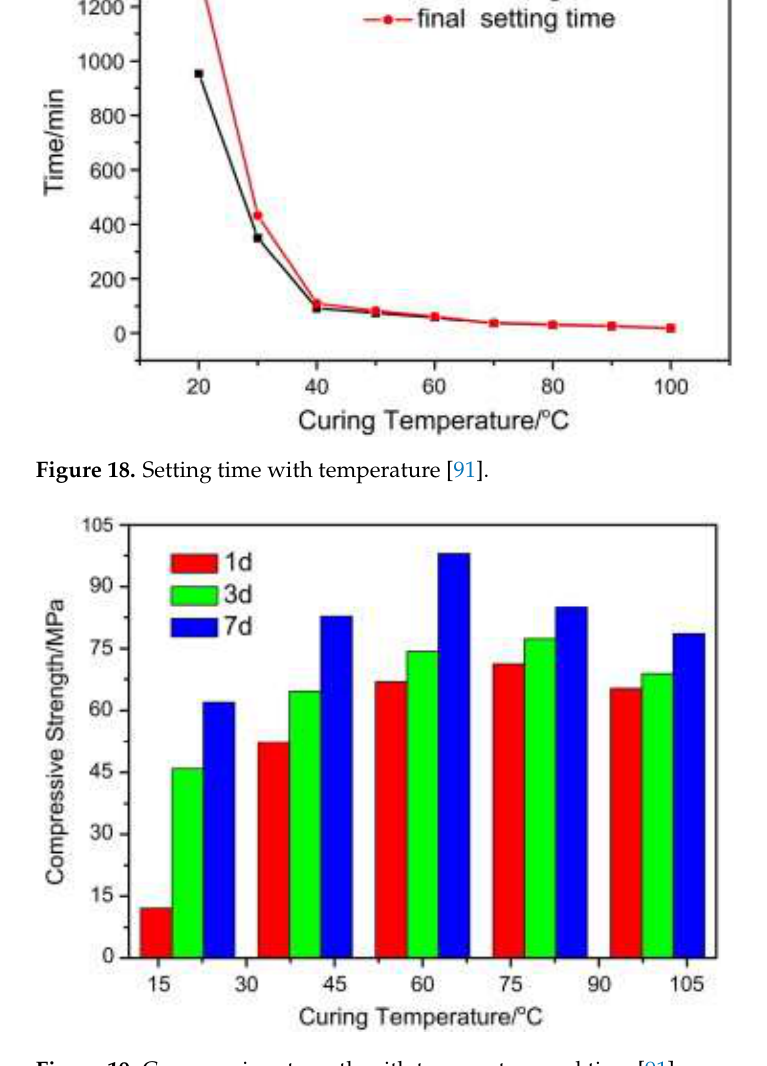
Figure 19. Compressive strength with temperature and time [91].